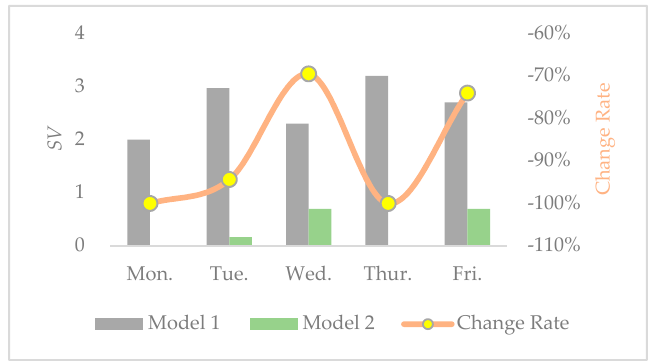
Figure 8. SV and change rate in the two models.